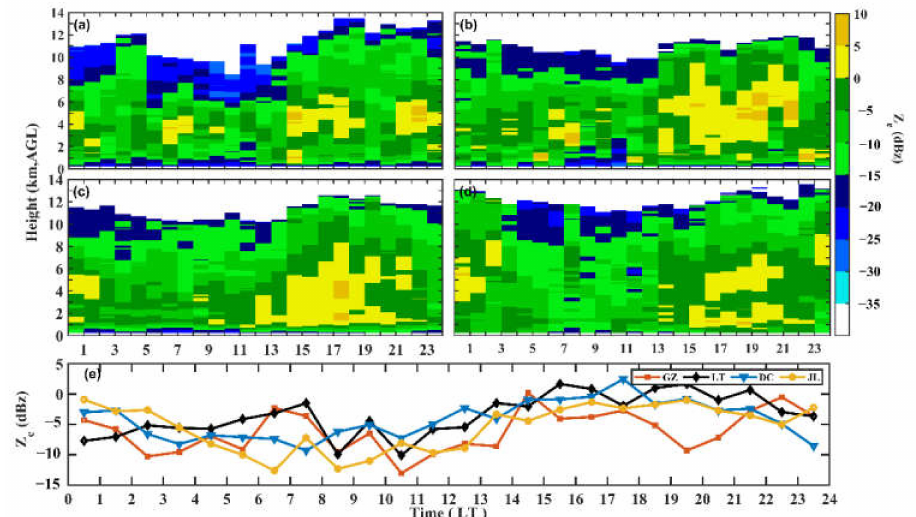
Figure 7. Diurnal variations of the radar reflectivity factor ( Z e ) at four sites. ( a ) GZ; ( b ) LT; ( c ) DC; ( d ) JL; ( e ) hourly changes of mean values of Z e